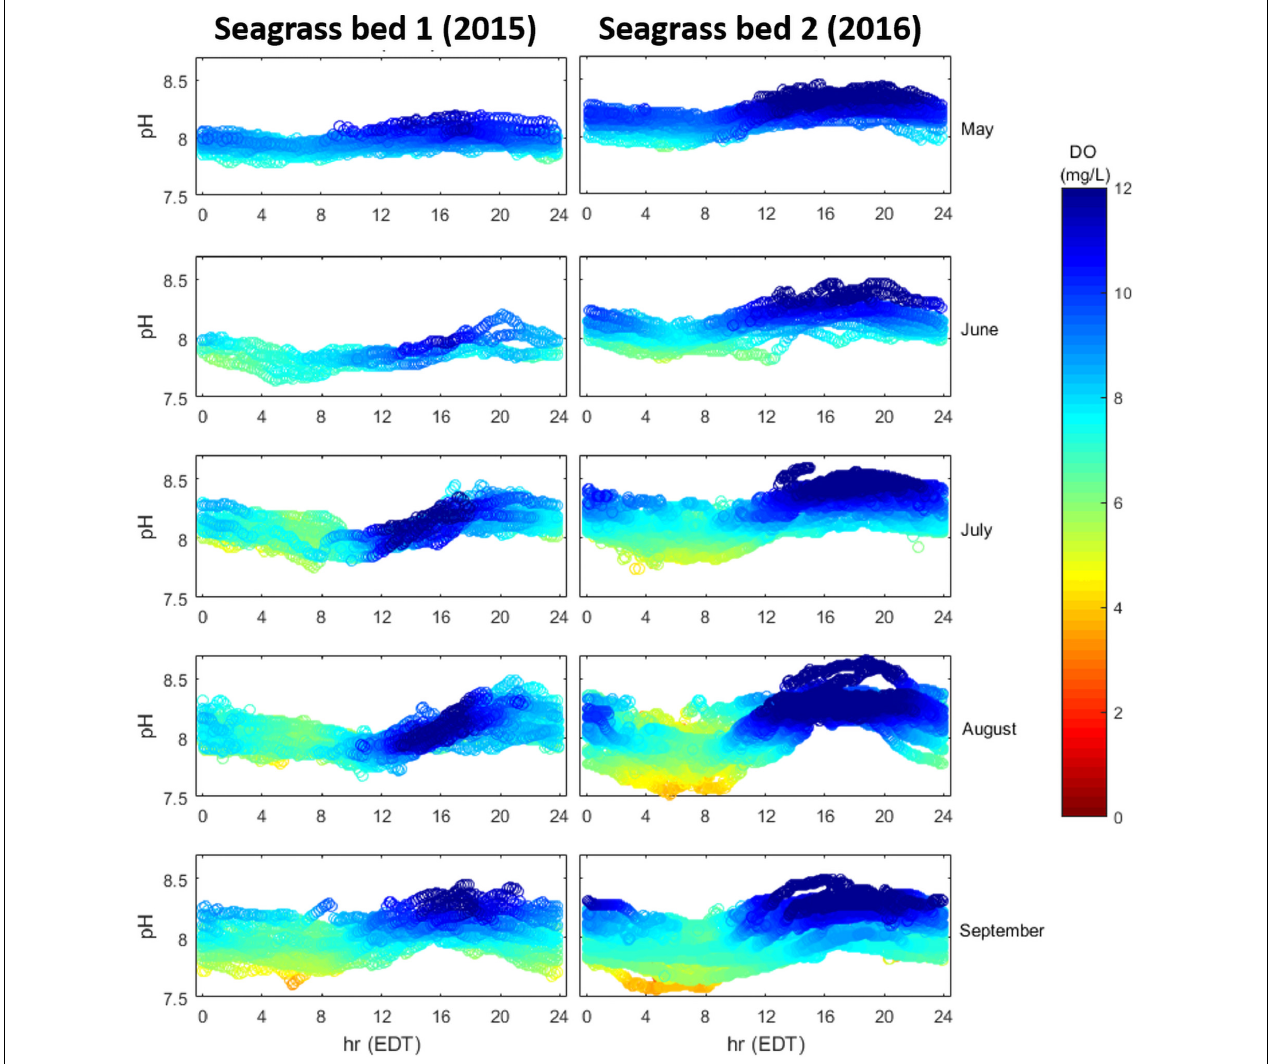
FIGURE 6 | Diurnal patterns of pH T (y-axis) and DO (mg L − 1 ; colormap) in two seagrass meadows (SG-1 and SG-2), May–September, 2015 and 2016,